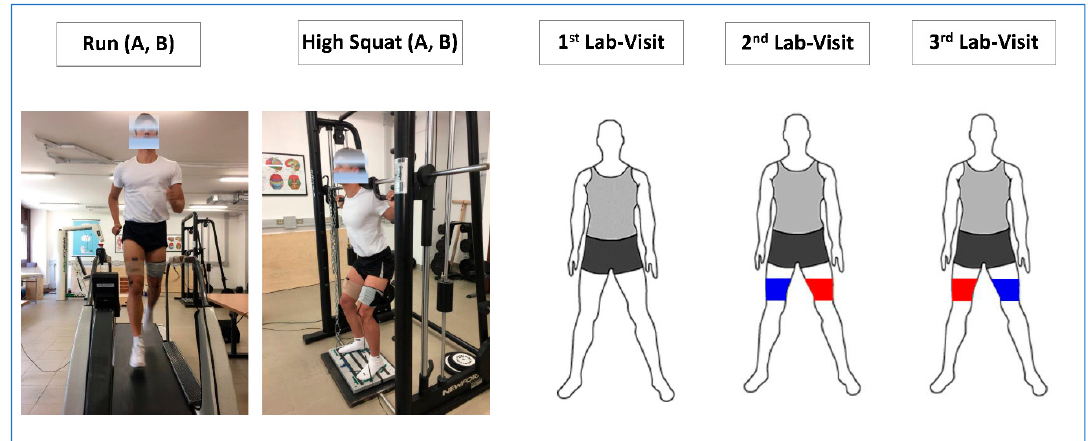
Figure 2. Design of the study. 1st Lab-Visit: participants familiarized themselves with the experimental procedures. 2nd Lab-Visit: Session A: participants performed the maximal isometric voluntary contractions (MIVCs) during High Squat (A), dynamic High Squat (A) and run (A). The positioning of wiNIREM on one leg and the gold standard instrument on the other leg was random. 3rd Lab-Visit: Session B: participants performed MIVCs (B), dynamic High Squat (B), and Run (B). The positions of the wiNIREM and the “gold standard” instrumentations were swapped with respect to those in Session